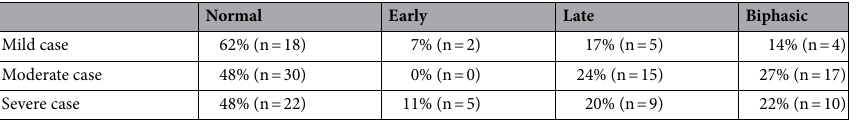
Table 2. Differences in the frequency of abnormal APTT second-derivative waveforms according to the severity of COVID-19 subjects. χ 2 <